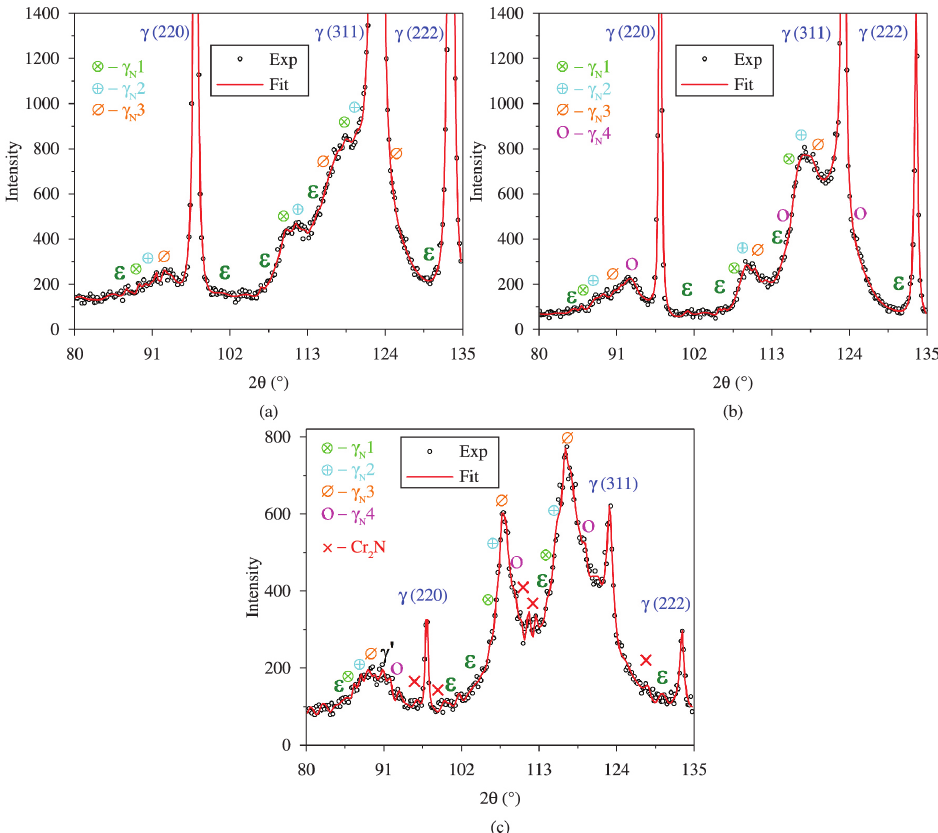
Figure 3. Zoom of the region between (220) and (222) reflections of Figure 3, for (a) 350, (b) 400 and (c) 450